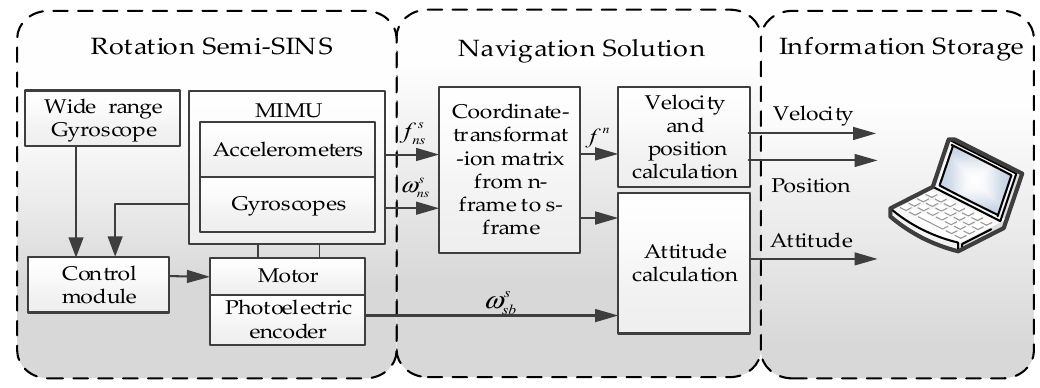
Figure 2. The principle block diagram of rotary semi-strapdown inertial navigation system (RSSINS).